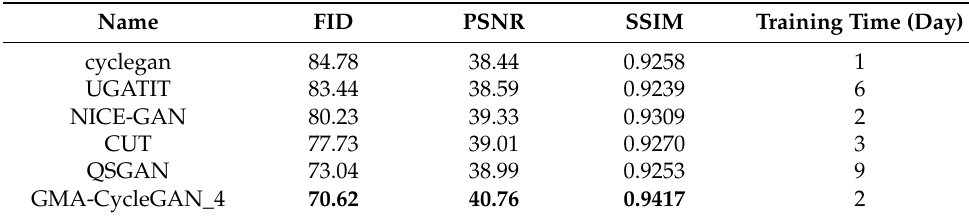
Table 2. Results of different